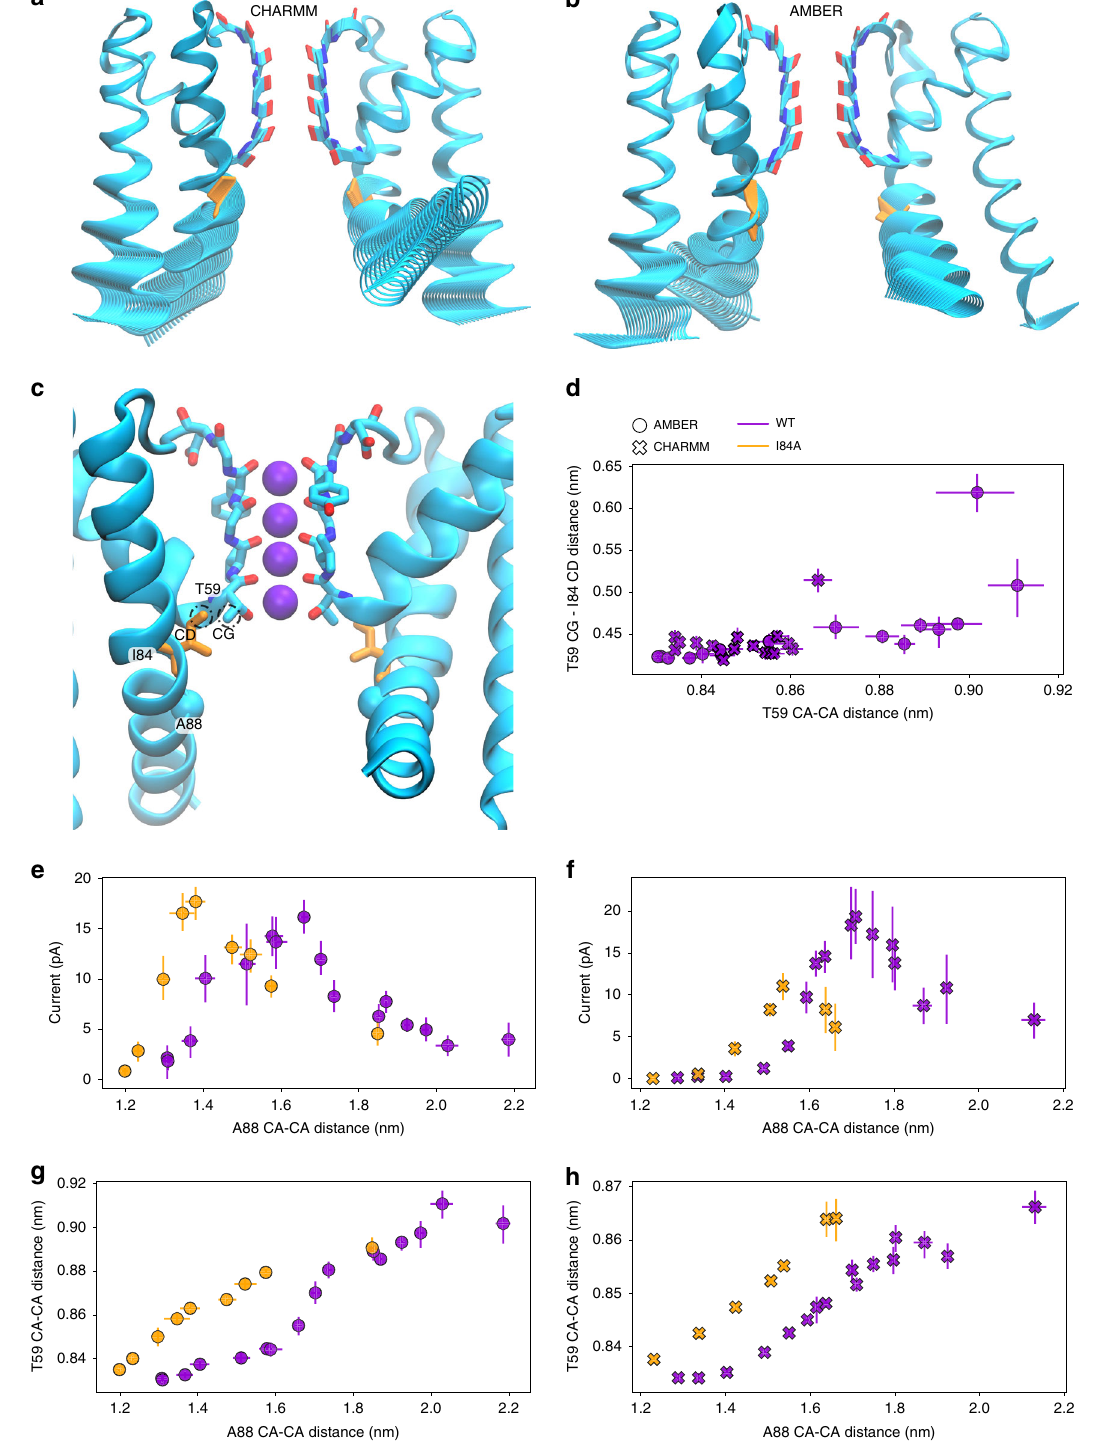
Fig. 5 Transmission of the allosteric signal from the activation gate to the selectivity fi lter. a , b Visualization of the collective motion (ewMCM) of MthK that underlies SF widening at T59, in CHARMM and AMBER force fi elds, respectively. Lower parts of both outer and inner (M1 and M2, respectively) contribute the most to this motion. c Location of I84 in the crystal structure of MthK (PDB ID: 3LDC), in close proximity to T59. d Distance between I84 side chain (I84 CD) and T59 side chain (CG) as a function of channel opening at T59. e , f Comparison of the outward K + current through MthK at 300 mV in WT and I84A mutant, for both AMBER and CHARMM force fi elds, respectively. g , h Correlation between AG opening (A88 CA – CA distance) and SF opening (T59 CA – CA distance) in both AMBER and CHARMM force fi elds, respectively. Error bars represent 95% con fi dence intervals. Source data are available as a Source Data fi